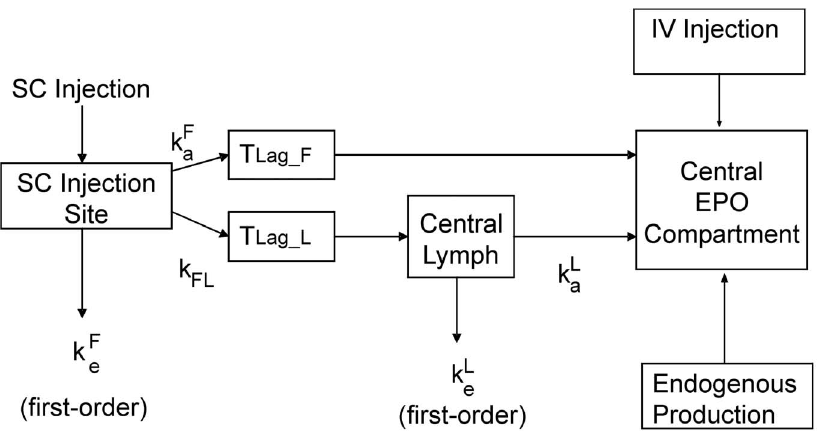
Figure 3. Structure of the EPO injection model with two ways of EPO absorption. The model is in analogy to [14]. Boxes denote the compartments, arrows represent EPO fluxes between the compartments.